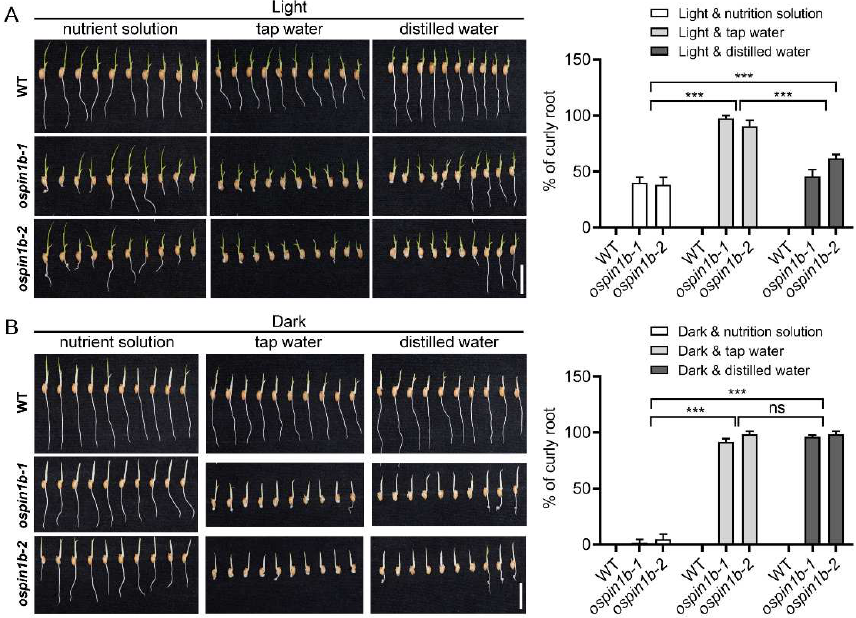
Figure 9. Root phenotype of wild-type (WT) and ospin1b mutants cultured under diverse conditions. ( A ) Rice plants were cultured with nutrient solution, tap water or distilled water in light. ( B ) Rice plants were cultured with nutrient solution, tap water or distilled water in the dark. Bar = 2 cm. Values are means ± standard deviation (SD) ( n ≥ 36). Data were analyzed by ANOVA and Tukey’s tests. ***: p < 0.001.